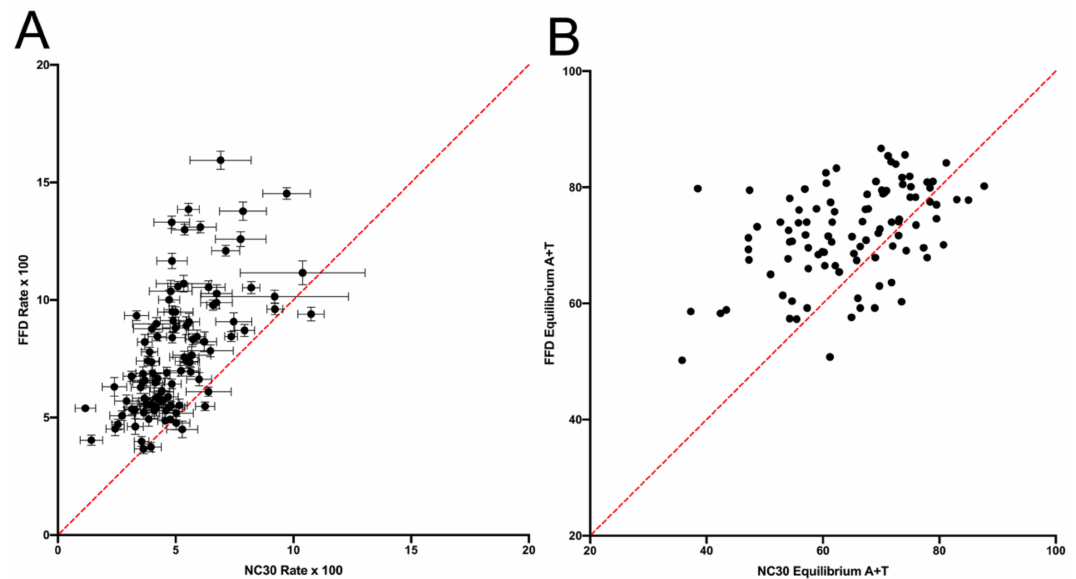
Figure 5. Comparison of ( A ) substitution rate and ( B ) predicted equilibrium A+T content for FFD sites and NC sites within 30 nucleotides of a start or stop codon (NC30